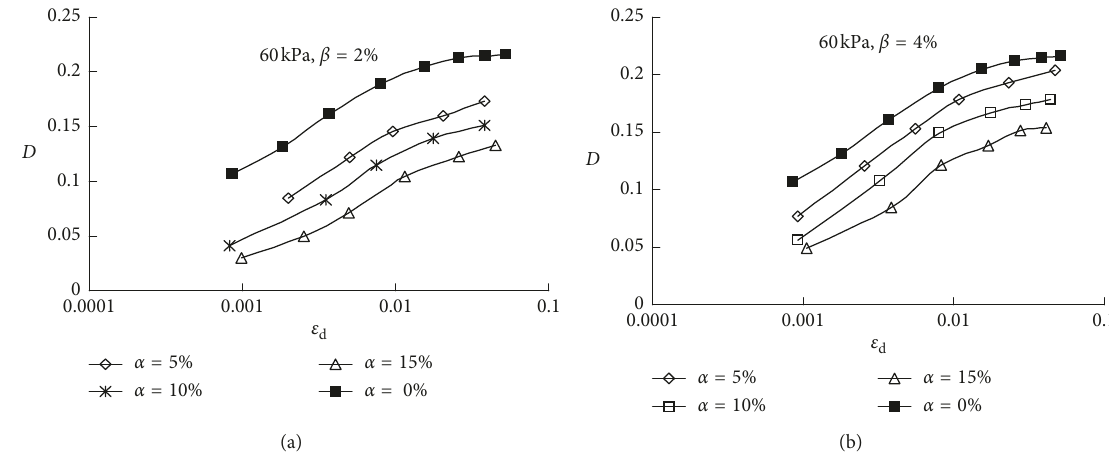
Figure 12: Relationship between the damping ratio and dynamic strain of LCES and clay at different cement content.